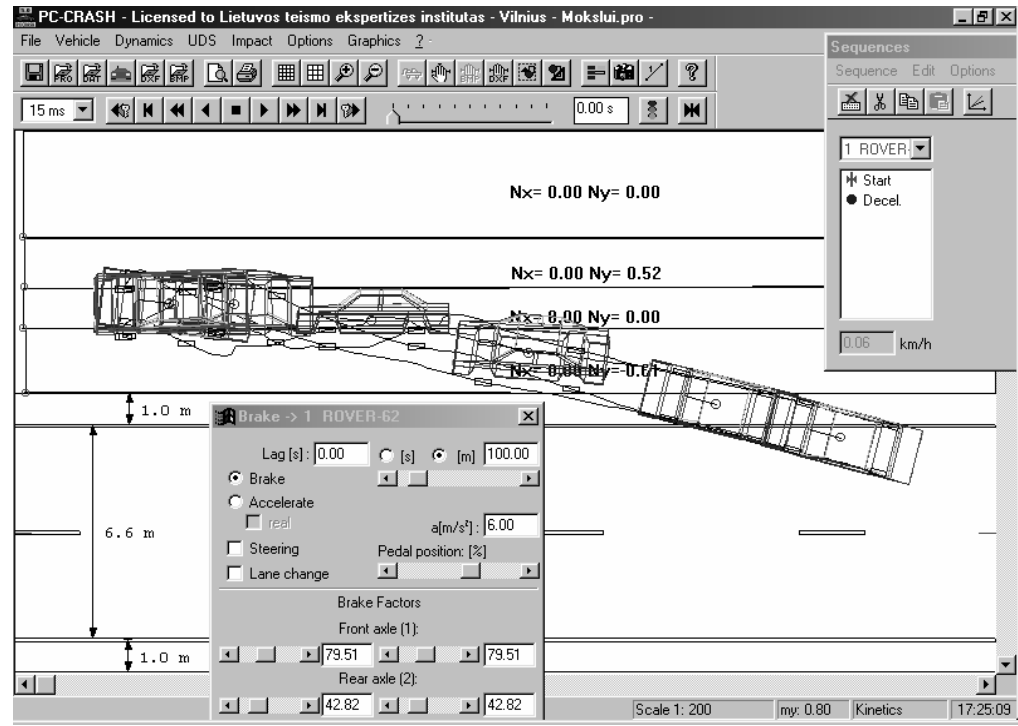
Fig 5. The view of overturning of the automobile from